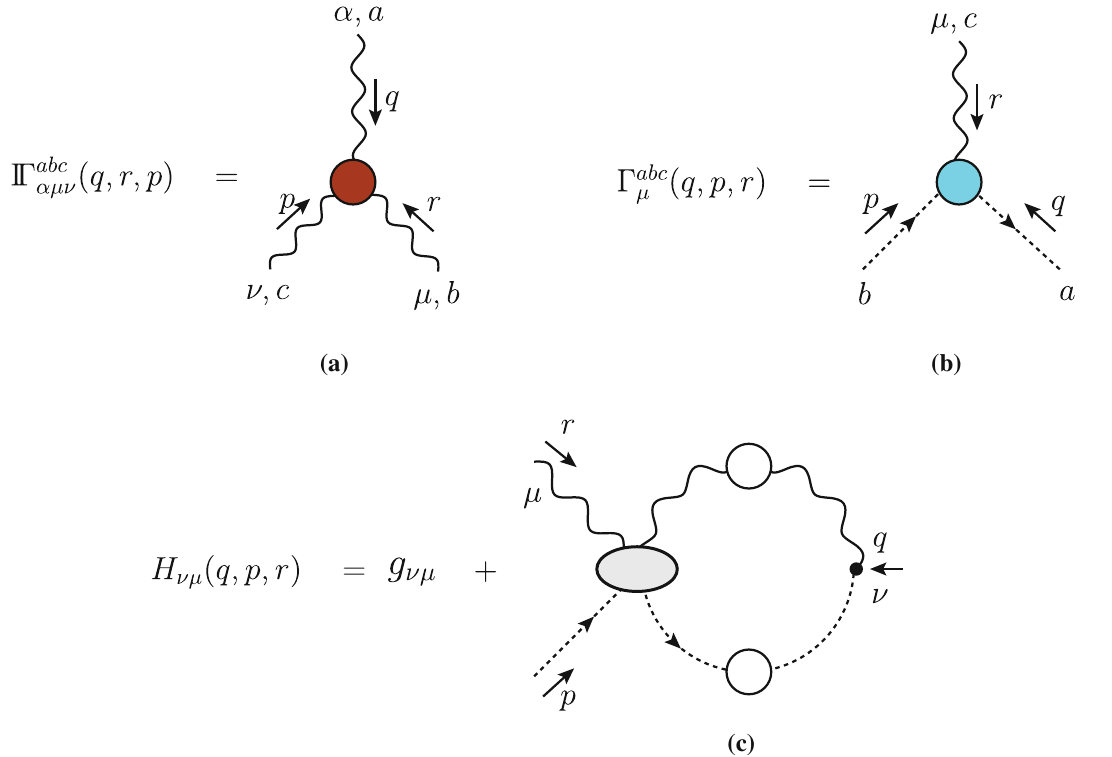
Fig. 1 Diagrammatic representations of the three-gluon vertex, I (cid:2) abc αμν ( q , r , p ) , the ghost-gluon vertex, (cid:2) abc μ ( q , p , r ) , and the ghost-gluon kernel, H abc νμ ( q , p , r ) [diagrams ( a ), ( b ), and ( c ), respectively], with the corresponding momentum conventions